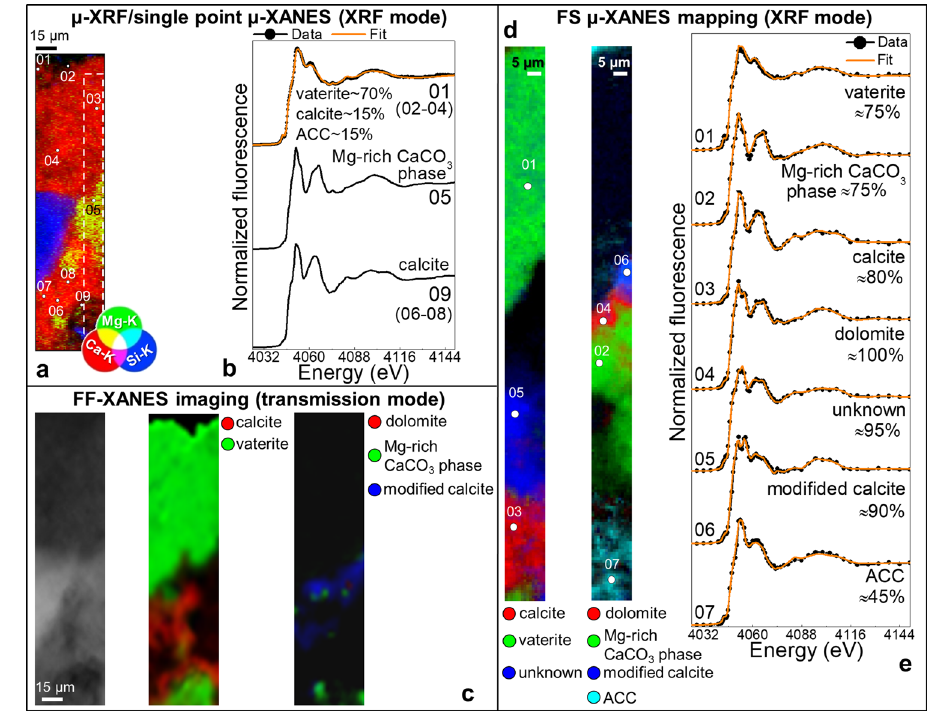
Figure 5. (a) RGB µ-XRF maps of Ca/Mg/Si recorded from a region of interest of sample L 1 [map size (h × v): 48 × 206 µm 2 ; step size (h × v): 1.5 × 0.6 µm 2 ; exp. time: 50 ms/pixel; energy: 4,400 eV] and (b) Ca K-edge µ-XANES spectra recorded from the spots shown in (a) (see Fig. 3b for the location of the mapped area). (c) Magnification of a region of sample L 1 analyzed by FF-XANES imaging: (from left) transmission image recorded at 3,918 eV and corresponding RGB Ca phase maps of calcite/vaterite and dolomite/Mg-rich CaCO 3 phase (cf. Fig. 3e to see the entire analyzed area). (d) Composite FS µ-XANES maps of (left) calcite/vaterite/ unknown Ca-based compound and (right) dolomite/Mg-rich CaCO 3 -phase/modified calcite/ACC recorded from the area indicated by the white-dotted rectangle in (a) [map size (h × v): 15 × 205 µm 2 ; step size (h × v): 1 × 1 µm 2 ; exp. time: 40 ms/pixel]. (e) Ca K-edge µ-XANES spectra (black) extracted from region of interests of the FS μ-XANES stack shown in (d) (average pixel number: 3–5) and corresponding LSLC fit result of different Ca-based compounds (orange) (only the relative amount percentage of the main phase is reported; for details see Supplementary Information, Table S1). Data were processed by means of PyMca 41 , ATHENA 44 and TXM- Wizard 40